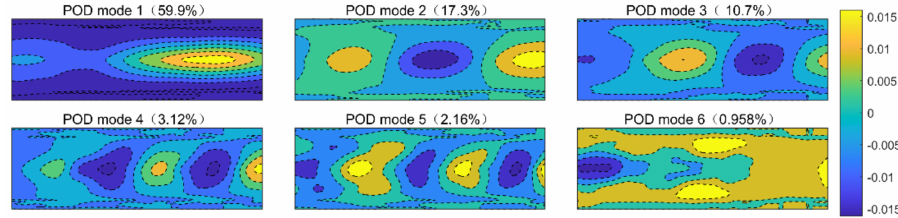
Figure 16. POD modes of the density